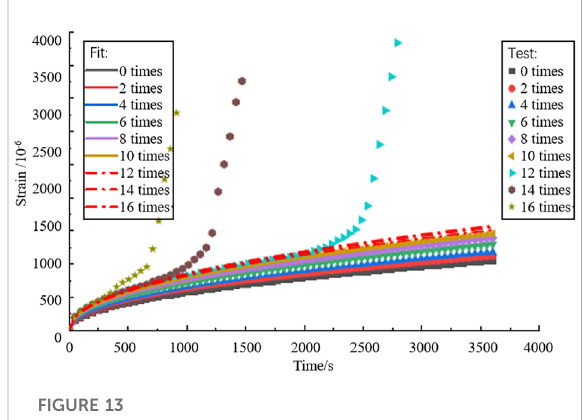
FIGURE 13 Creep fi tting curve of composite modi fi ed OGFC freeze- thaw damage at mixing ratios of (12%,1%).